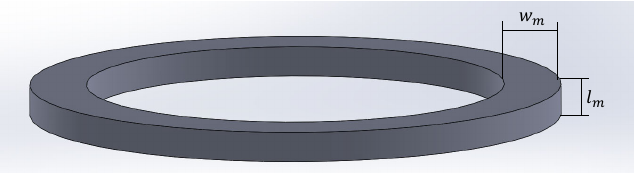
Figure 10. PM ring main dimensions.